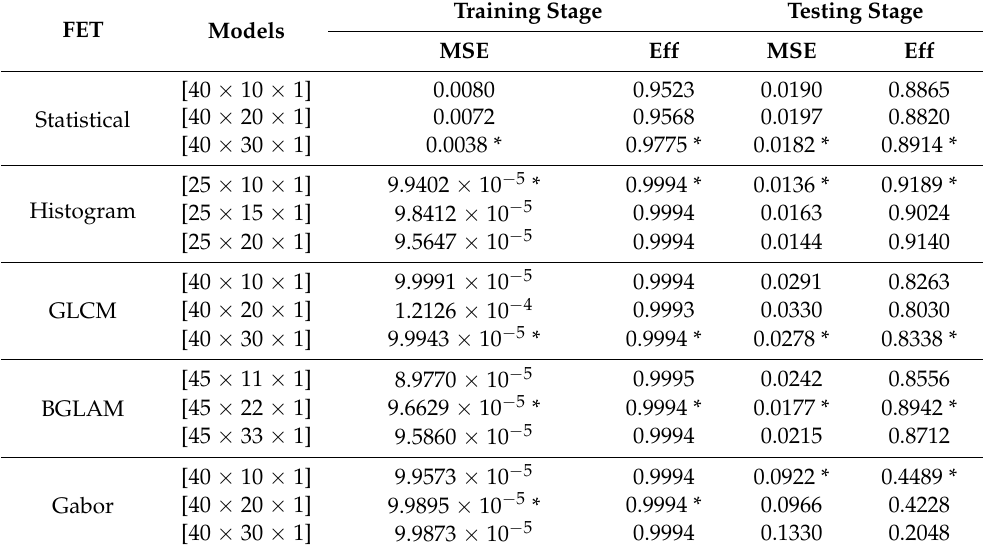
Table 3. MSE and efficiency result comparison of the training and testing stages based on the FFB feature